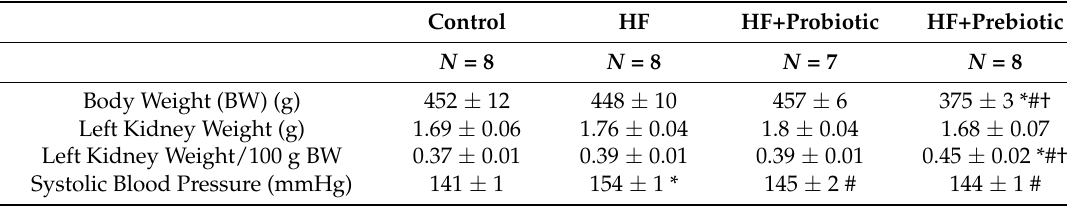
Table 2. Summary of morphological values and blood pressure